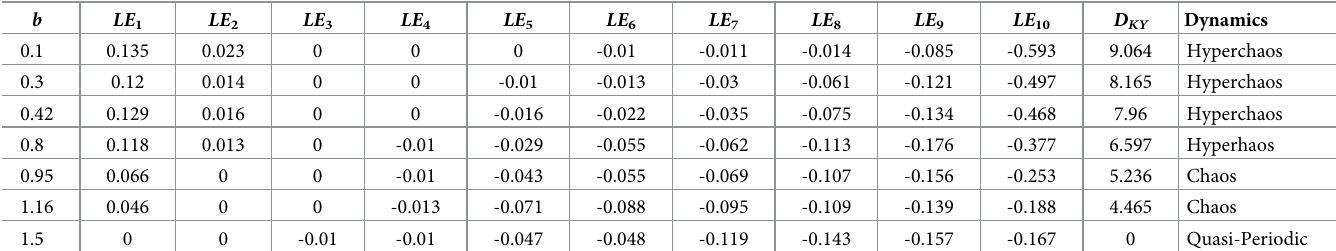
Table 3. Lyapunov exponents, Kaplan-Yorke dimension and dynamics of the new 10D system (1) with parameter b